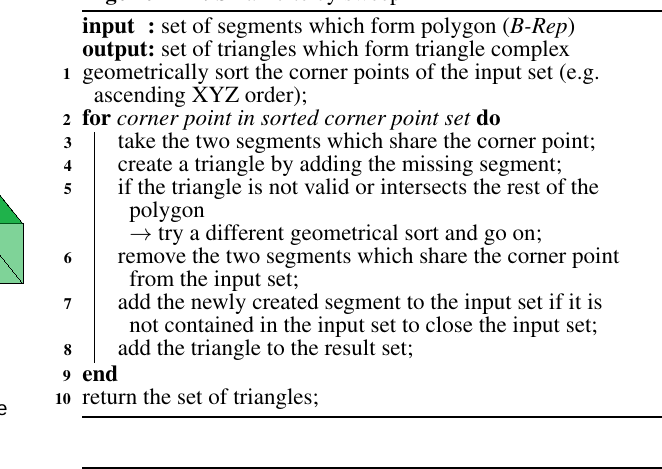
Algorithm 5: Big bite by